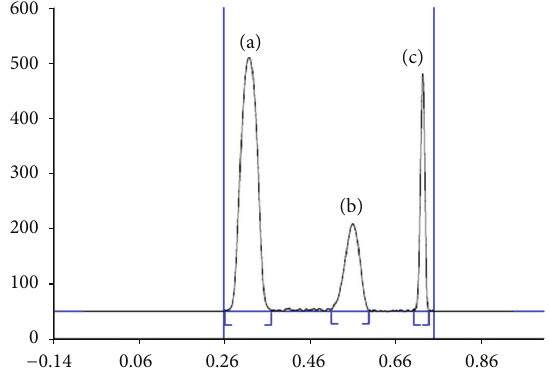
Figure 2: Representative chromatogram of OLM ( 𝑅 𝑓 0.29 ), HTZ ( 𝑅 𝑓 0.52 ), and IS ( 𝑅 𝑓 0.71 ).